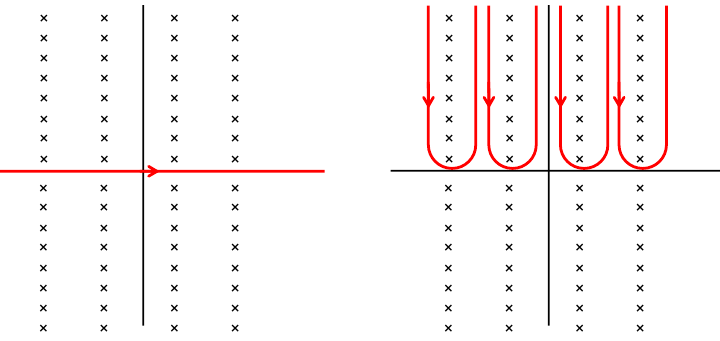
Figure 2 . The integration contour in the complex x plane along the real axis (left) is deformed for positive FI parameters (cid:16) so that it encloses sequences of poles in the upper-half plane (right).